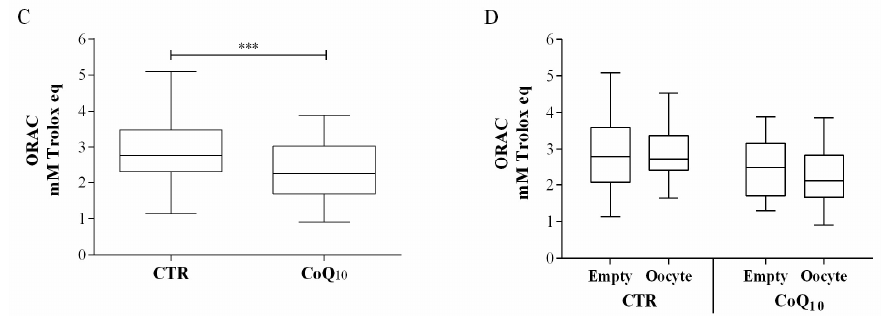
Figure 2. Follicular fluid (FF) coenzyme Q10 oxidative status and Oxygen Radical Absorbing Capacity (ORAC) in control (CTR n = 51) and supplemented IVF patients (CoQ10 n = 69). CoQ10 oxidation is expressed as % of oxidized CoQ10/total CoQ10 ( A , B ), while ORAC value is expressed as mMTrolox equivalents ( C , D ). Sub analysis in relation to oocyte content as % of oxidized CoQ10/total CoQ10 ( B ) or mMTrolox equivalents ( D ). ** p < 0.01; *** p < 0.001. (oocyte containing follicles n = 30 CTR; n = 44CoQ).